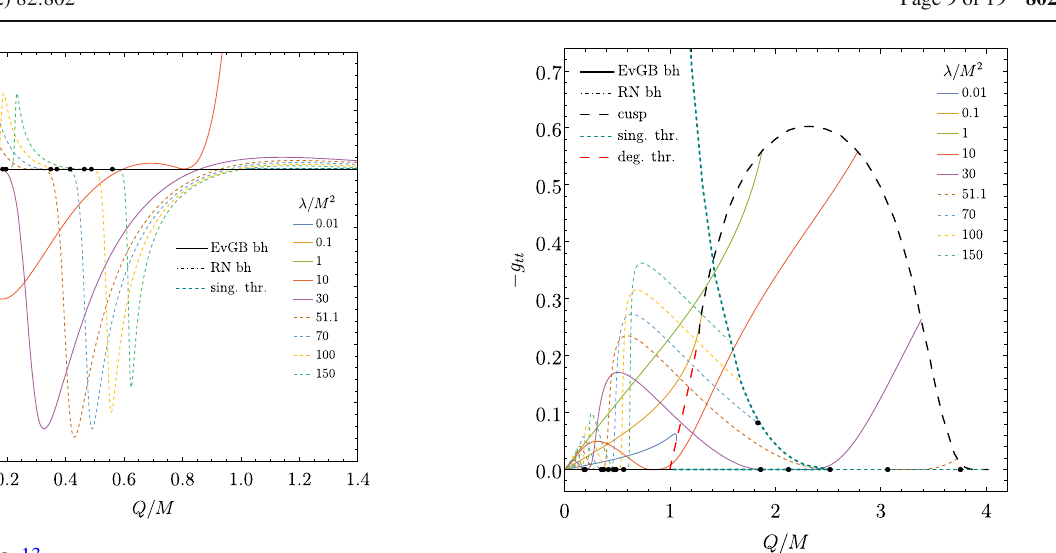
Fig. 14 Zoom of Fig. 13